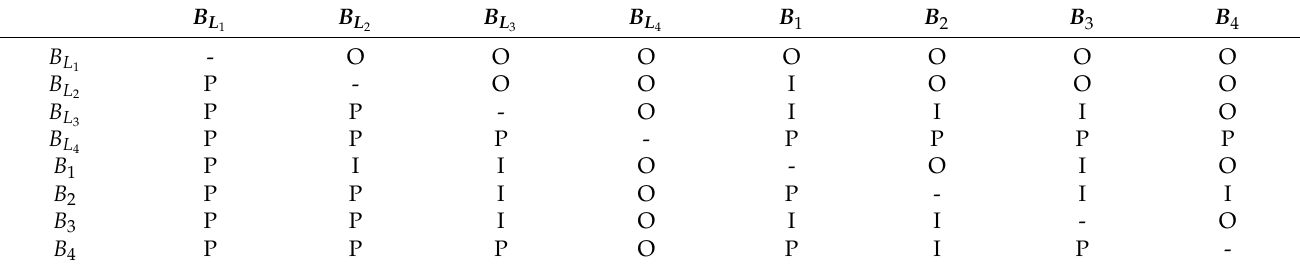
Table 10. PIR structure of